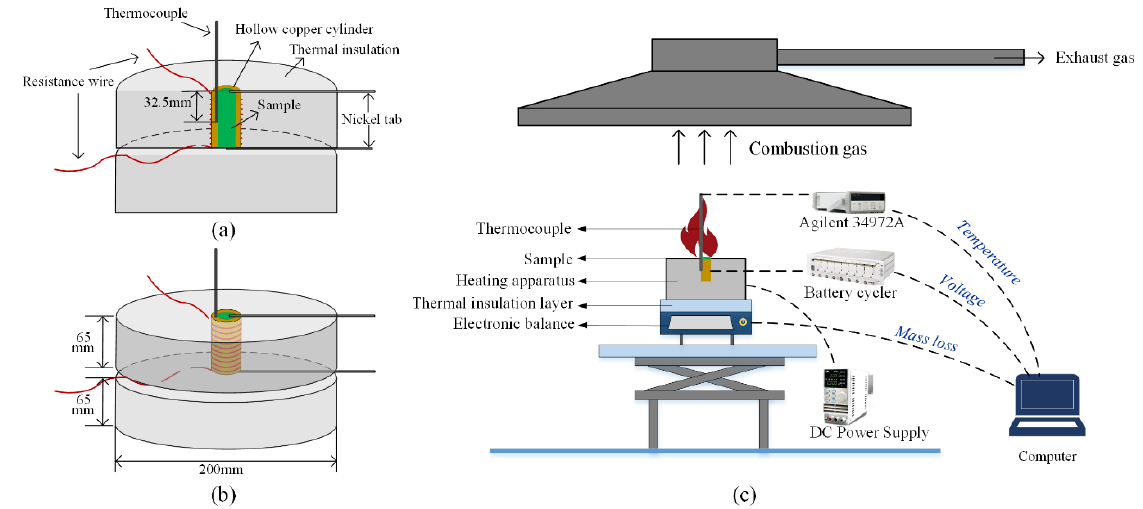
Figure 1. Vertical section view of the heating apparatus ( a ), Perspective view of the heating apparatus ( b ), and Schematic of the experimental setup ( c ).